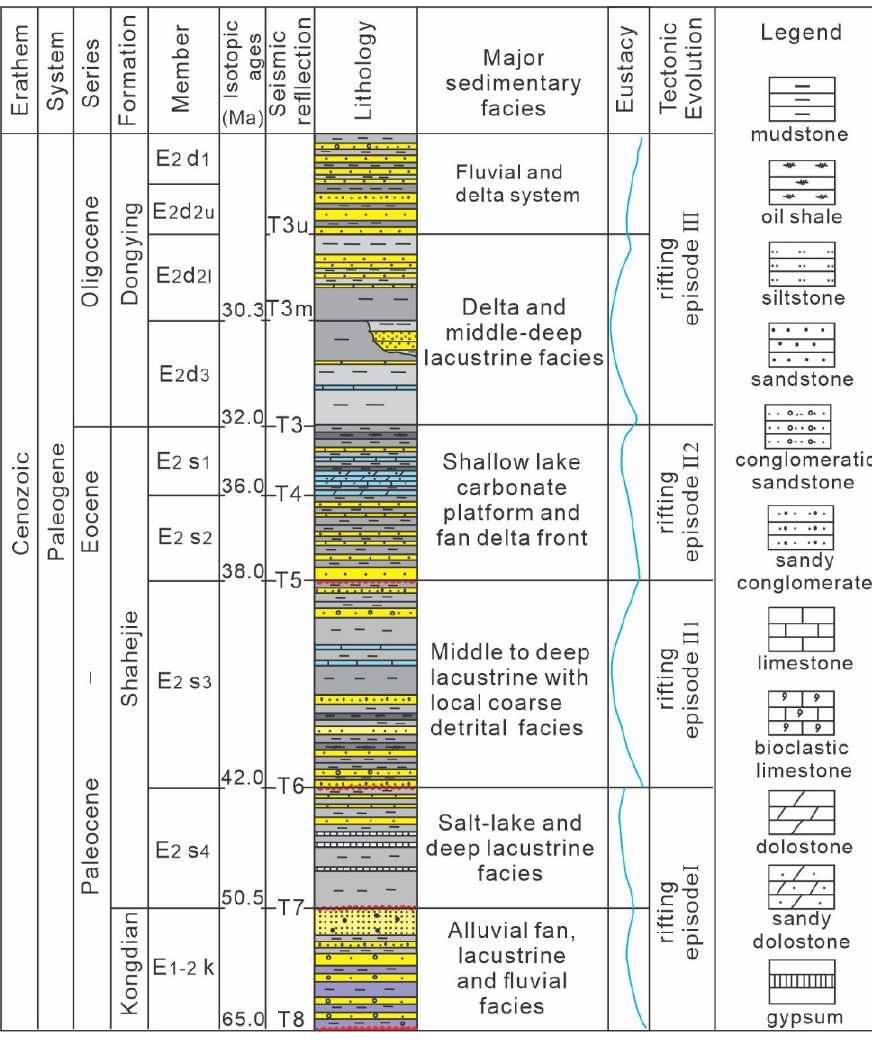
Figure 2. Generalized Cenozoic stratigraphy, facies, and tectonic events and stages of the Bohai Bay Basin.